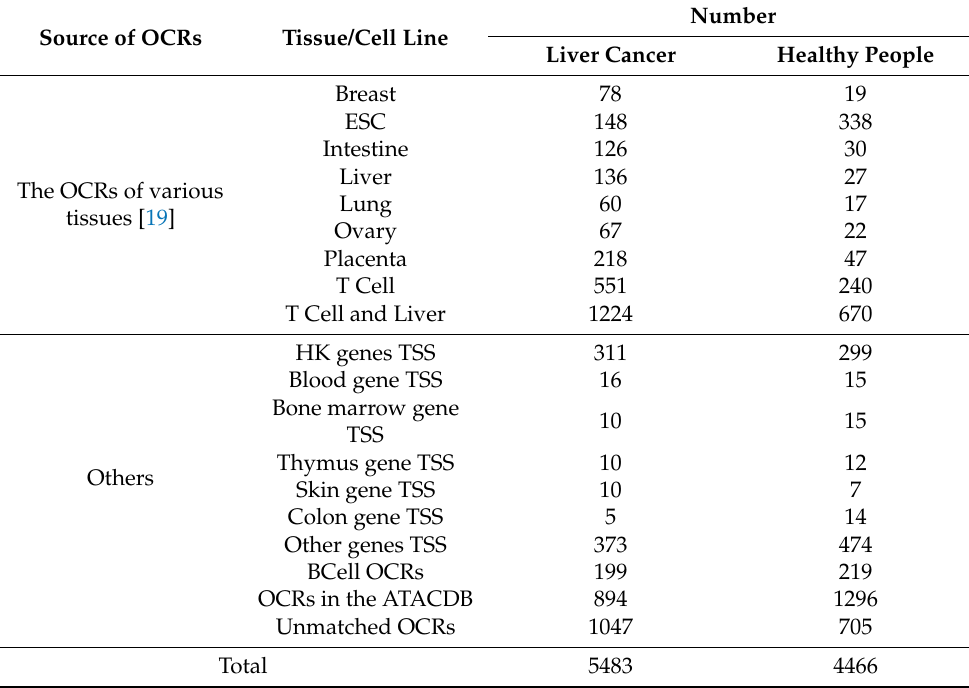
Table A1. The specific data of the components of Liver_OCRs and Heathy_OCRs.